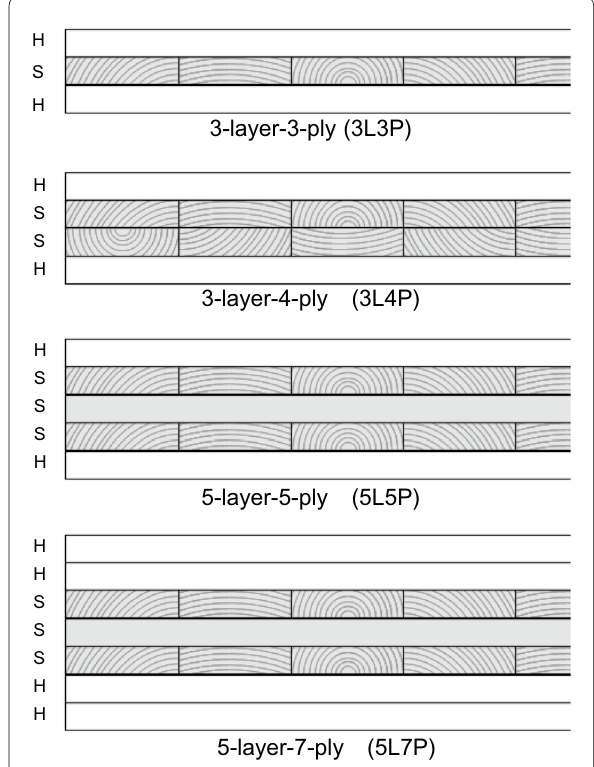
Fig. 1 Layer configurations of the tested CLT. H: hinoki (hinoki cypress), S: sugi (Japanese